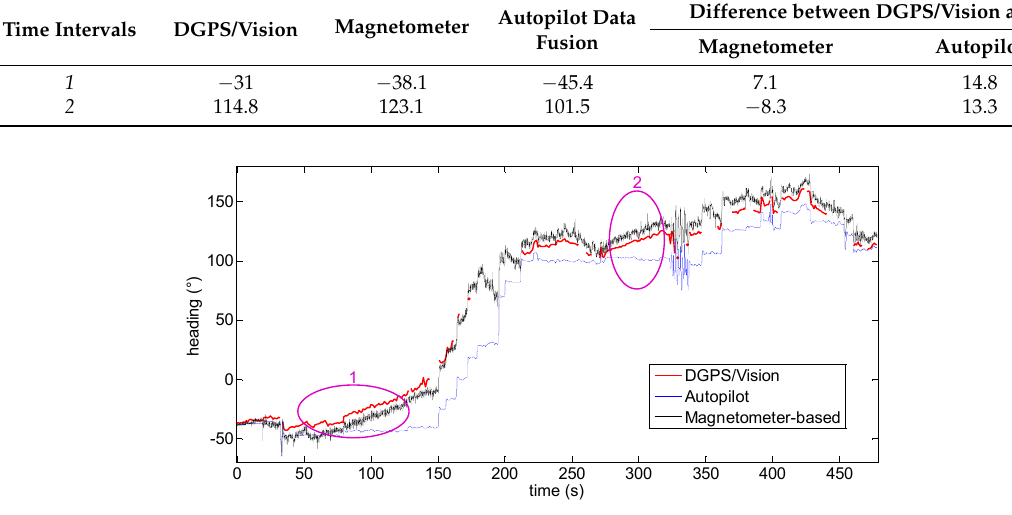
Figure 19. Heading as a function of time (Test 2).